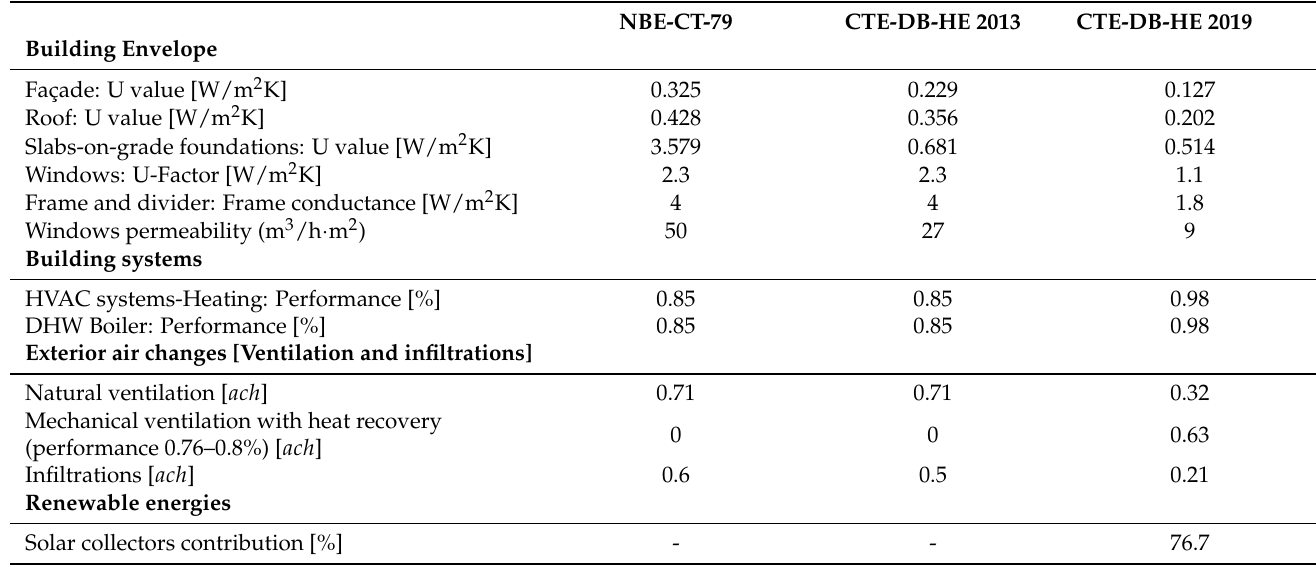
Table 2. General characteristics of the Building Energy Models according to the different Spanish technical building